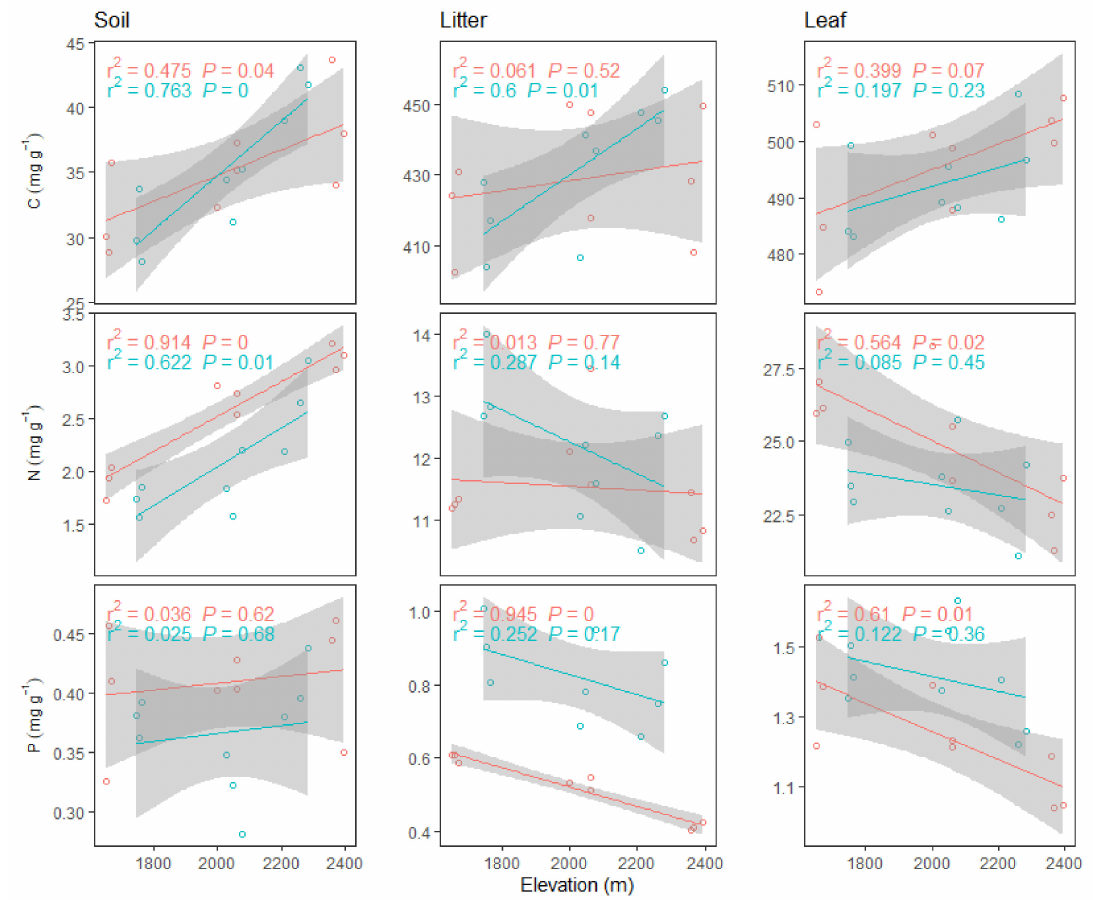
Figure 2. Changes in soil, litter and leaf carbon (C), nitrogen (N), and phosphorus (P) contents with altitudinal gradients for two stand origins of Larix principis-rupprechtii forests (red and blue are planted and natural, respectively). Lines and shade represent fitted regressions and corresponding 95% confidence intervals. Table 2. E ff ects of E (elevation) and M (management) on soil, litter, and leaf C, N, and P